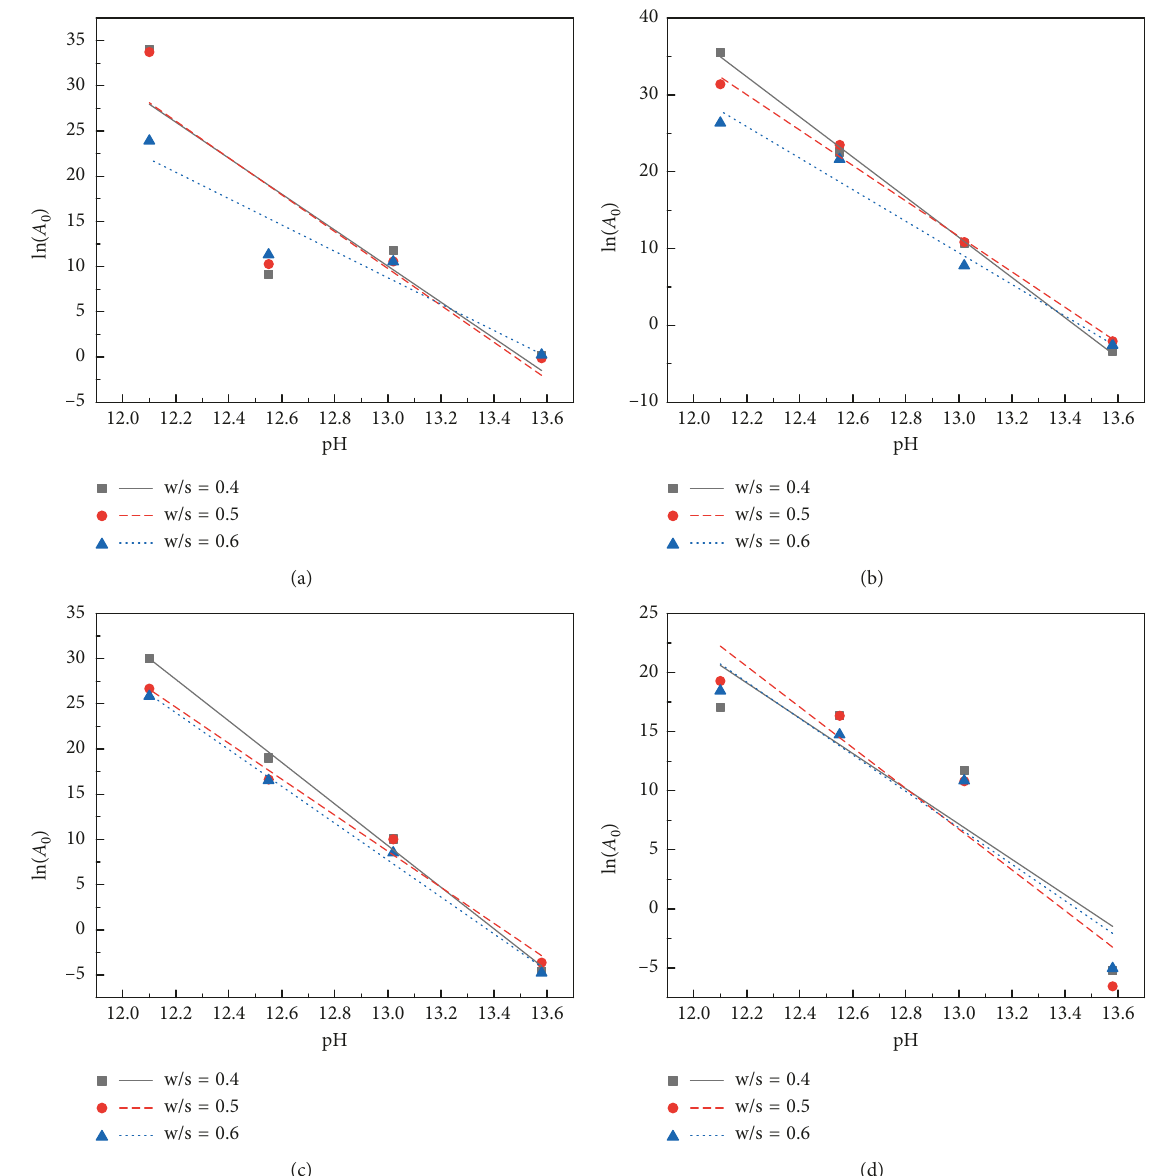
Figure 8: ln A changes with pH at (a) 1day, (b) 3days, (c) 7days, and (d) 0